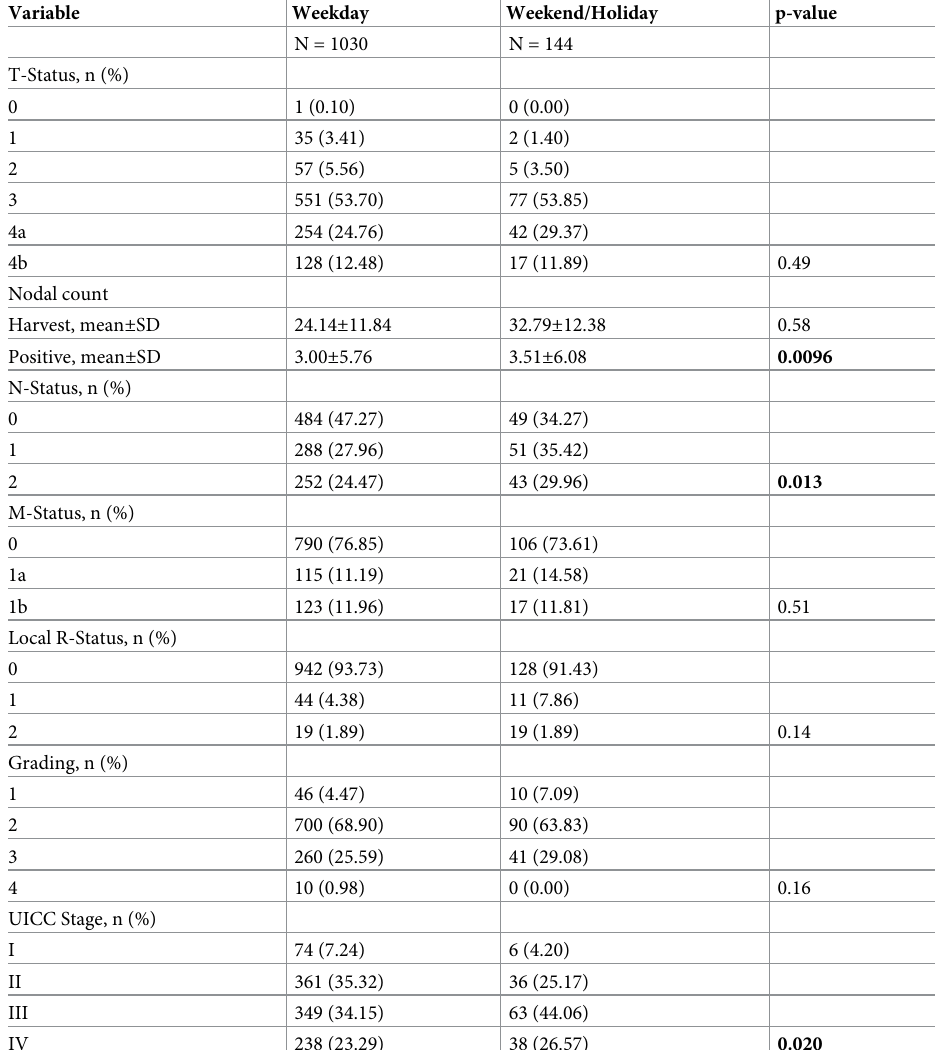
Table 3. Pathological results by weekday of